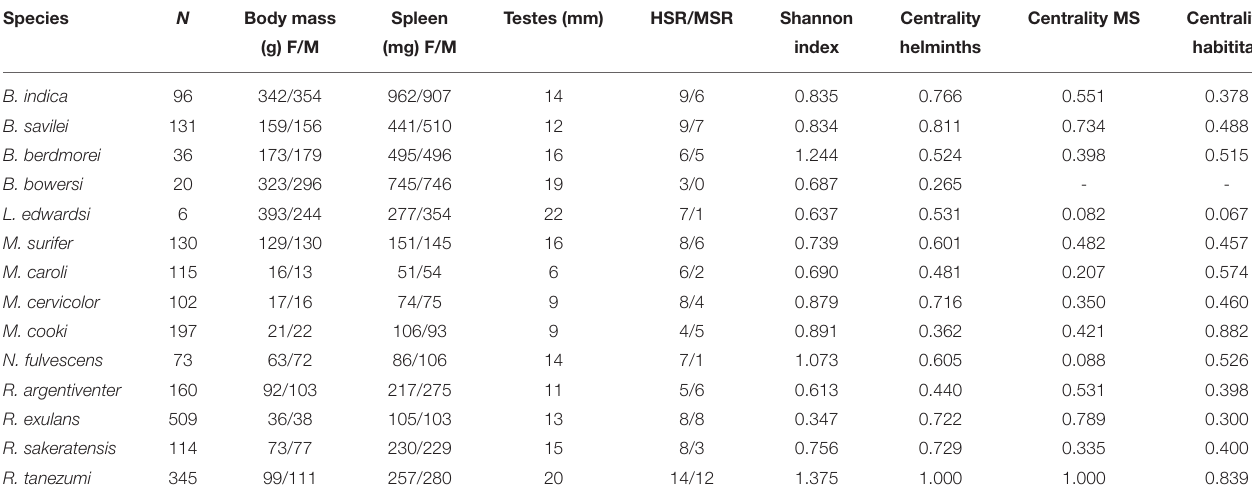
TABLE 1 | Values of centralities of unipartite networks of shared helminth species, shared rodent-borne diseases, and shared habitat, with values of Shannon index. Species N Body mass Spleen Testes (mm) HSR/MSR Shannon Centrality Centrality MS Centrality